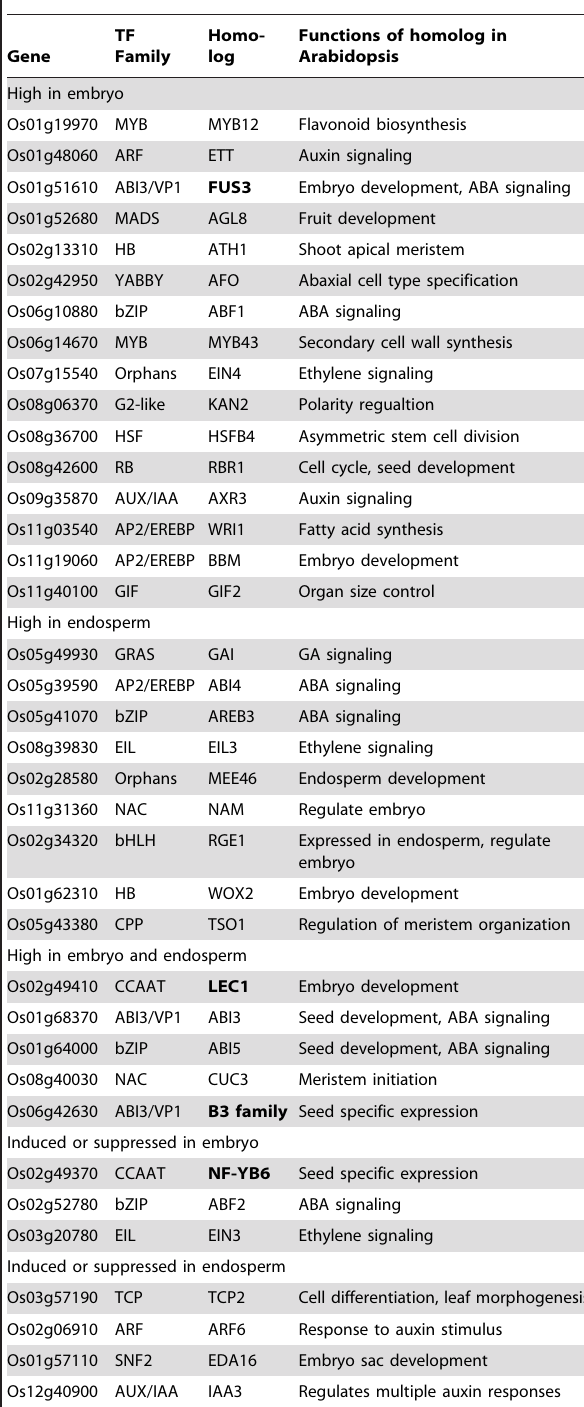
Table 1. Functions of conserved seed development- associated transcription